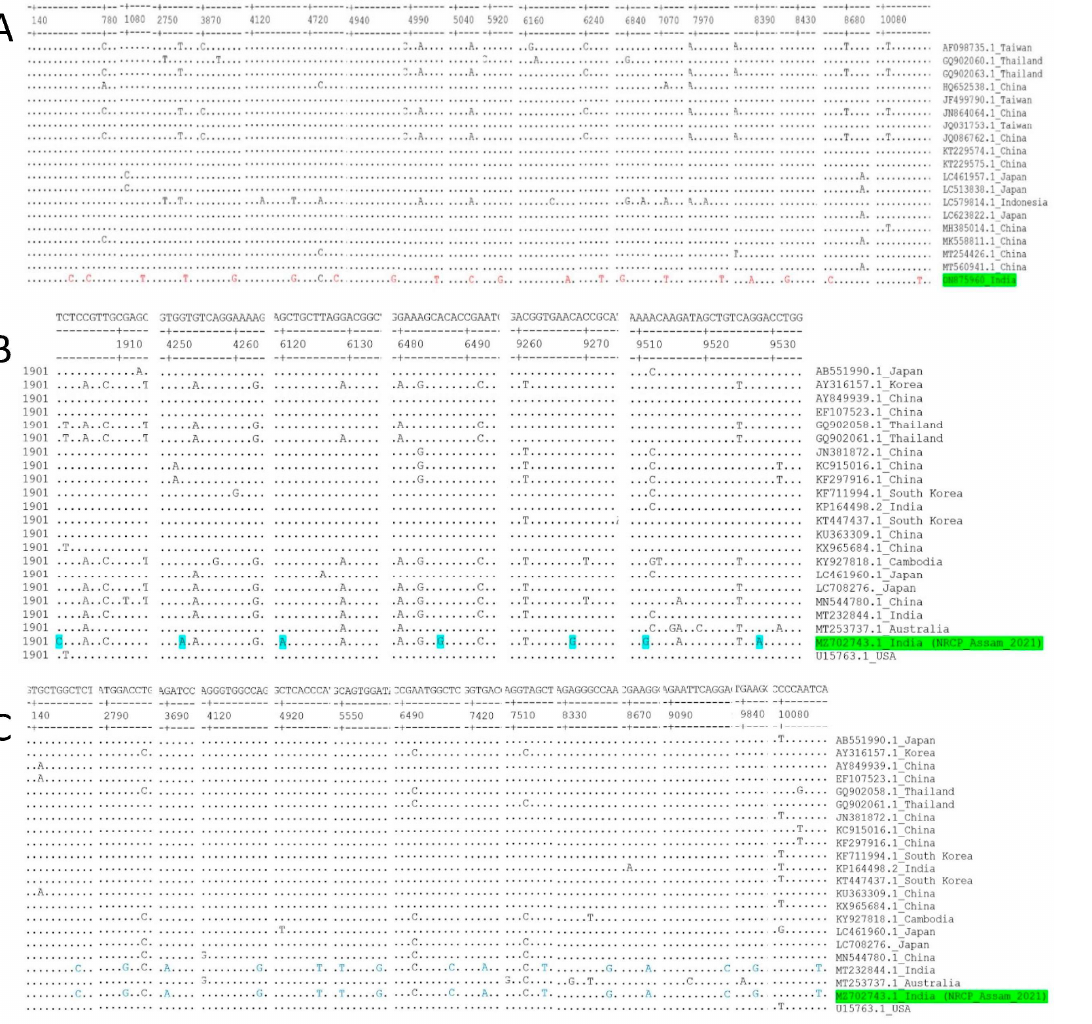
Figure 6. Nucleotide sequence alignment of the polyprotein genes of JEV isolates from mosquito ( A ), pig ( B ) and unique nucleotide mutations identification in Indian isolate of current study. ( C ) Common and unique nucleotides mutation of polyprotein genes of JEV isolates from two Indian strain. Residues identical to the consensus are indicated by dots.